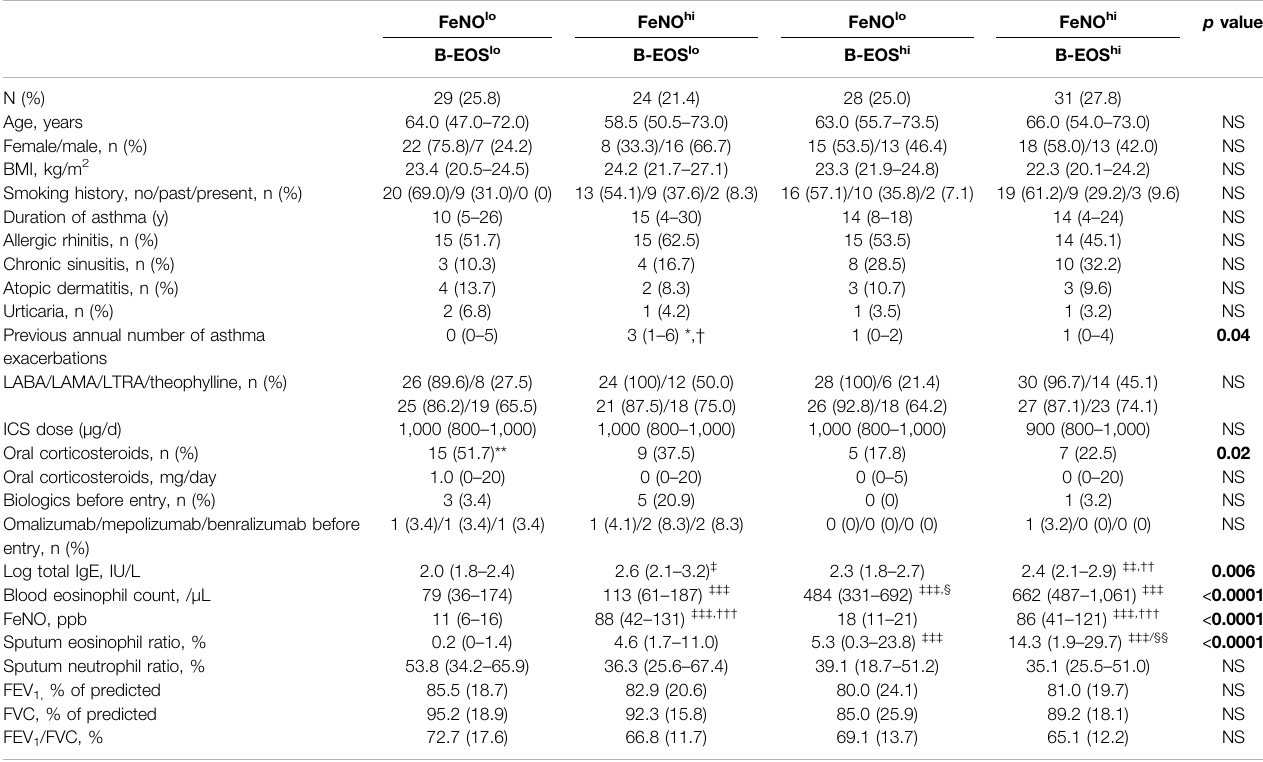
TABLE 2 | Demographics and clinical characteristics of patients with asthma in the subgroups classi fi ed by type 2 biomarker at entry. FeNO lo FeNO